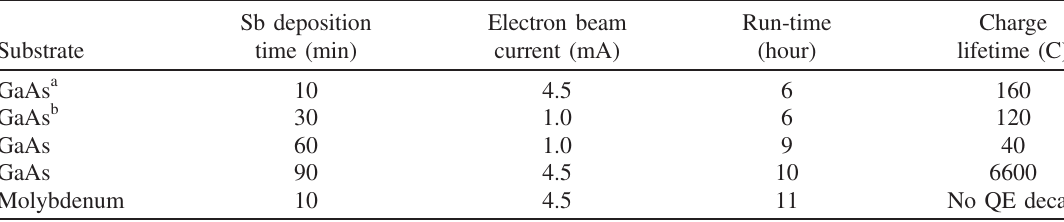
TABLE III. Photocathode charge lifetime summary.